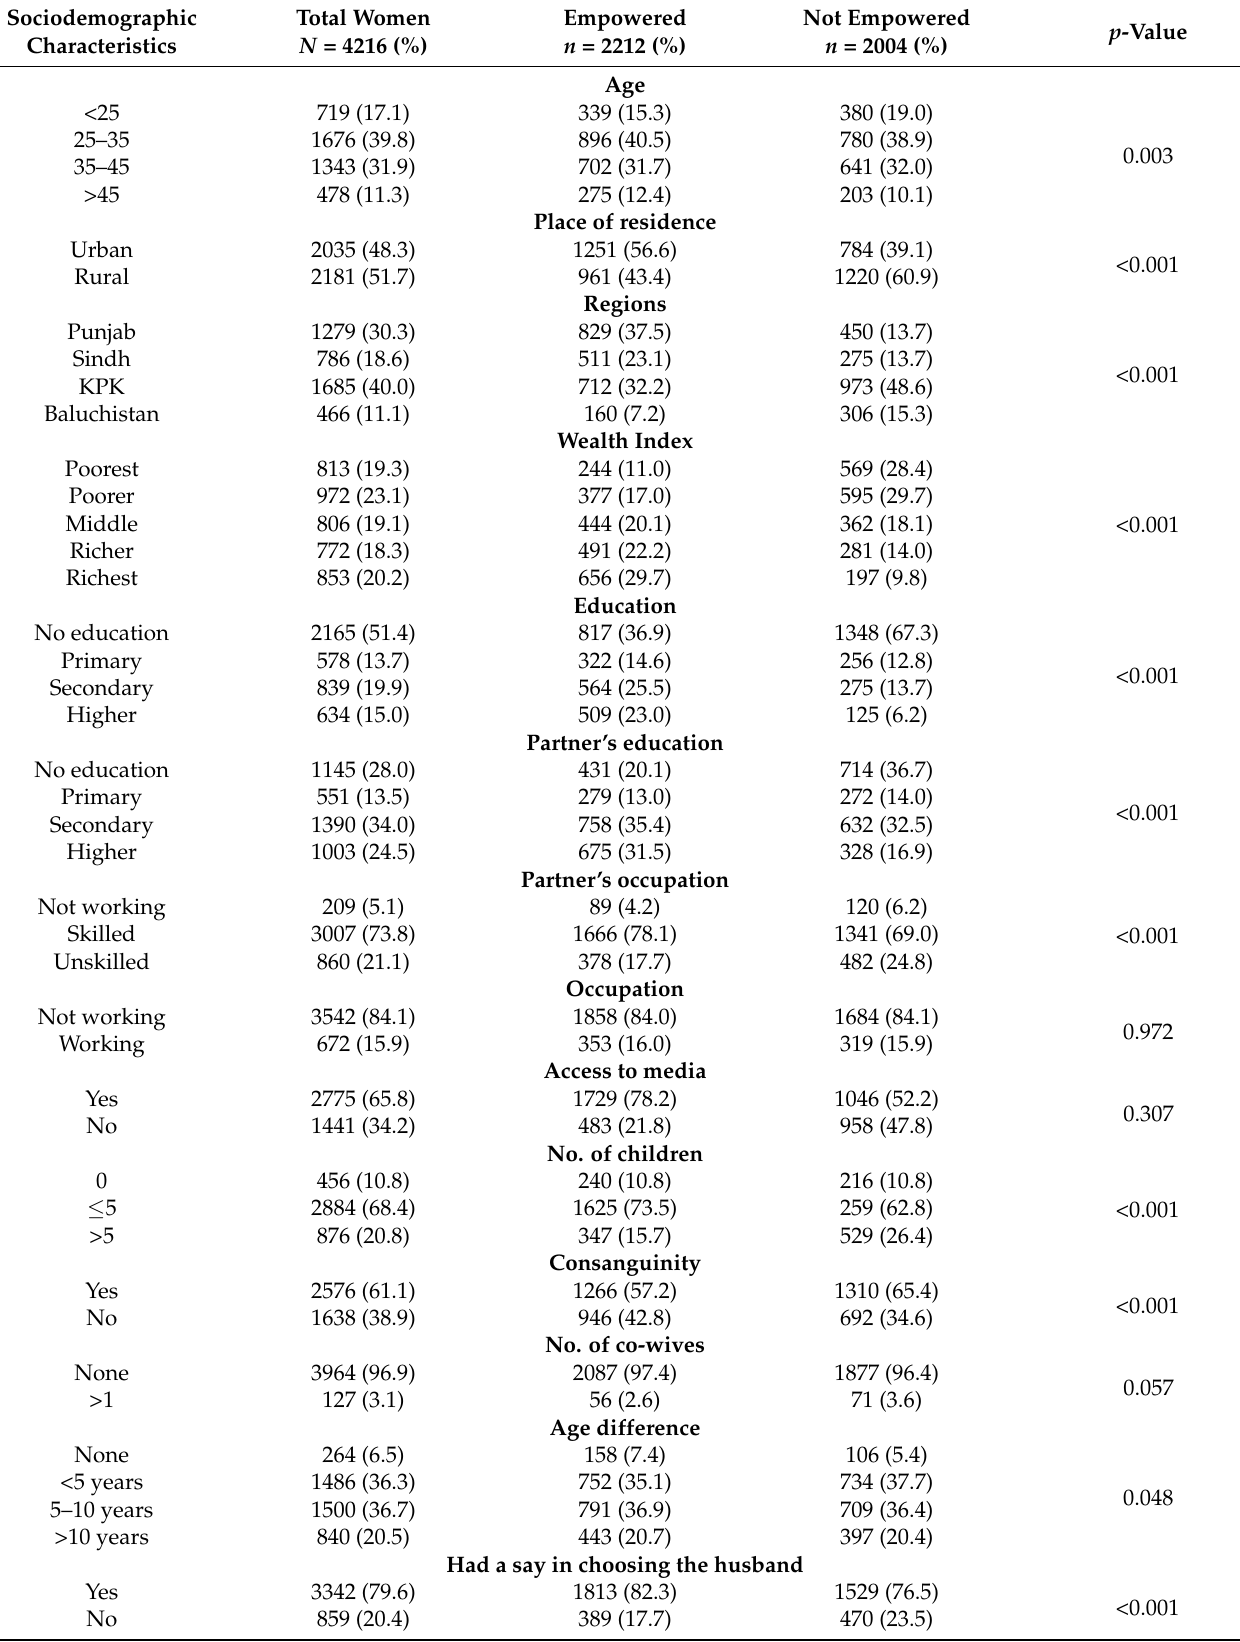
Table 1. Sociodemographic characteristics of empowered women ( N =